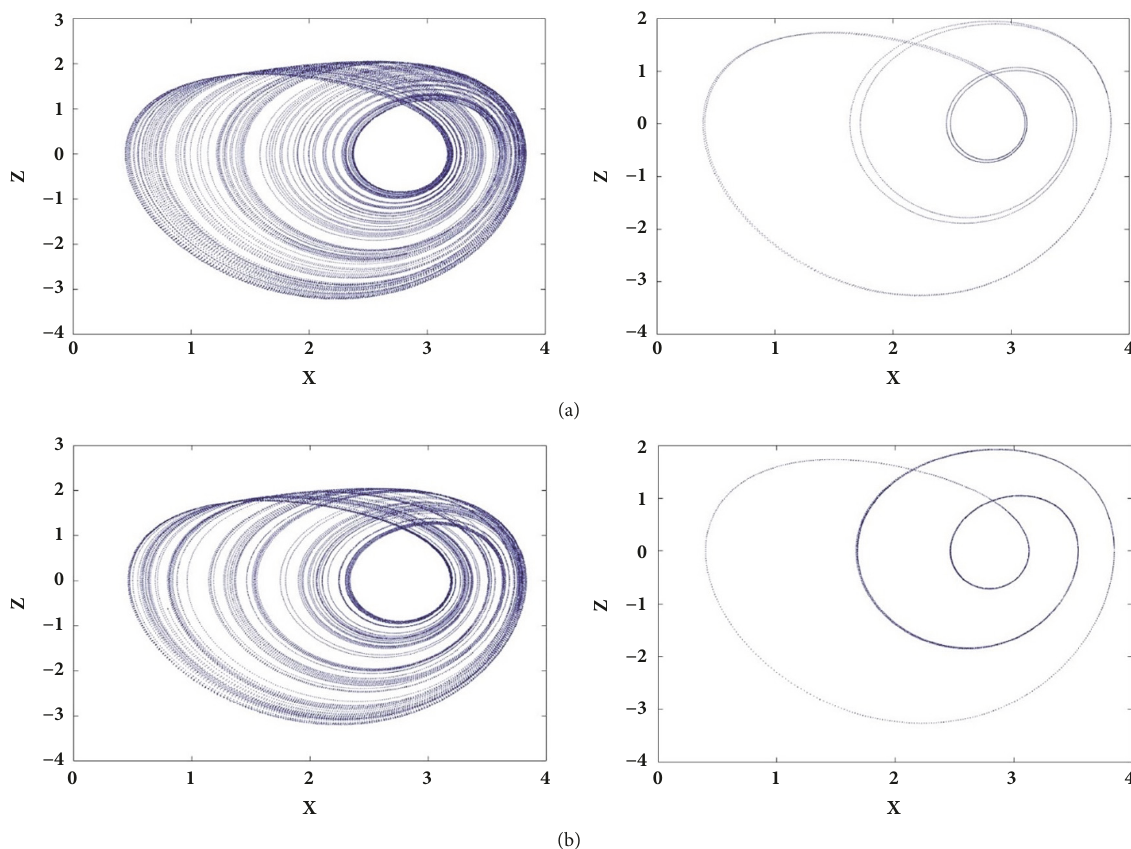
Figure 10: (Color online) Phase portraits in the plane (𝑥,𝑧) of the FPGA implemented proposed autonomous jerk oscillator for specific values of parameter 𝑏 : (a) 𝑏 = 3.185 and (b) 𝑏 = 3.189 for the initial conditions (x(0), y(0), z(0)) = (1.0, 0, 0.5) in left column and (x(0), y(0), z(0)) = (3.0, 0, 0.5) in right column with the value of the parameter 𝑎 = 3.3 . The step size is taken as ℎ = 0.001